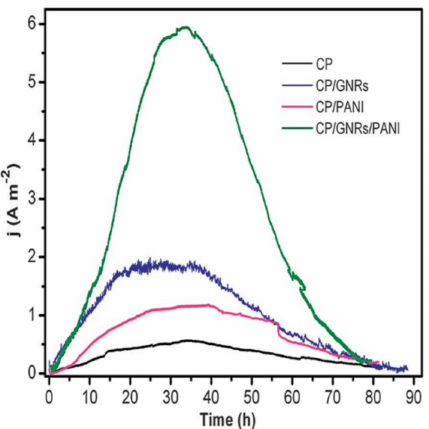
Figure 10. Current generation by S. oneidensis in ECs equipped with different anodes